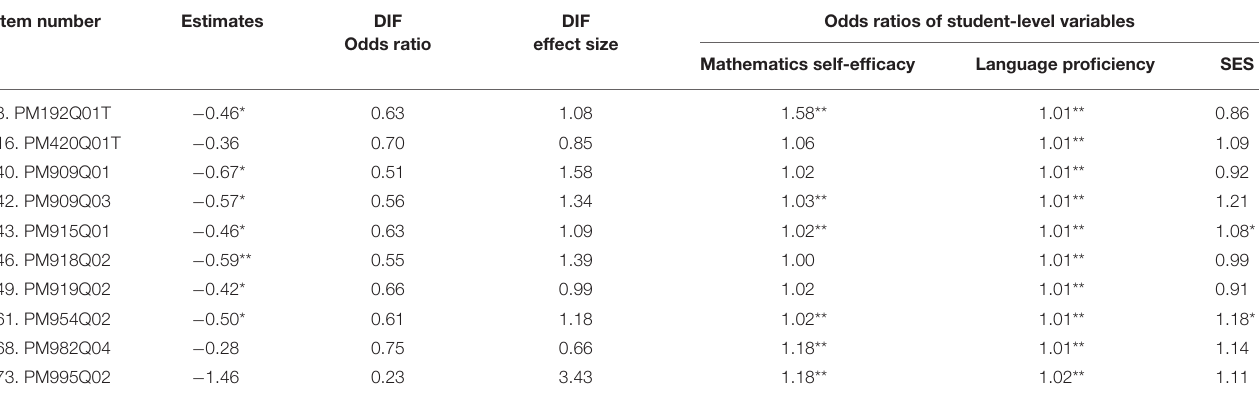
TABLE 5 | Summary of results from HGLM Model 2. Item